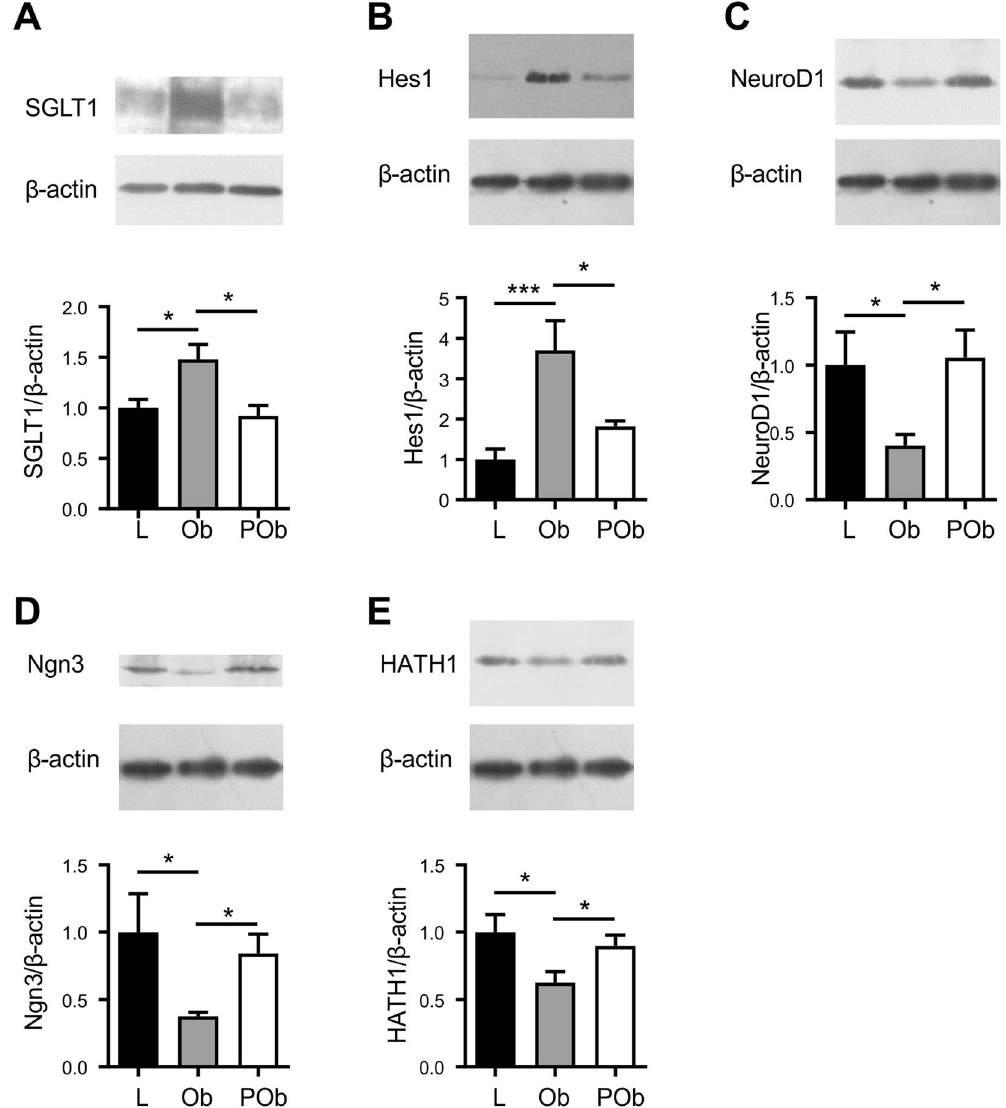
Figure 5. SGLT1, Hes1, NeuroD1, Ngn3, and HATH1 protein expression (western blot) in duodenal biopsies of lean, obese and post-operative. Protein contents of BBMV (20 µ g protein), or cell lysates (100 µ g protein) separated from duodenal biopsies were subjected to western blot analysis using antibodies to SGLT1 ( A ), transcription factors: Hes1 ( B ), NeuroD1 ( C ), Ngn3 ( D ), HATH1 ( E ) and β -actin; the latter was used as a loading control. Upper panel shows abundance of SGLT1, the transcription factor and β -actin proteins determined by western blots and lower panel depicts the densitometric analysis of western blots normalising protein abundance to that of β –actin: in lean (L) ( ■ ), obese (Ob) ( ) and post-operative obese, (POb) ( □ ) individuals. Results are shown as mean ± SEM; n = 7–10. Statistically significant results determined using a One-way ANOVA with differences between means identified using a Holm-Sidak multiple comparison post- test where * P < 0.05 and *** P < 0.001. For clarity, boxed western blot images are displayed. Full length blots are shown in Supplementary Figure